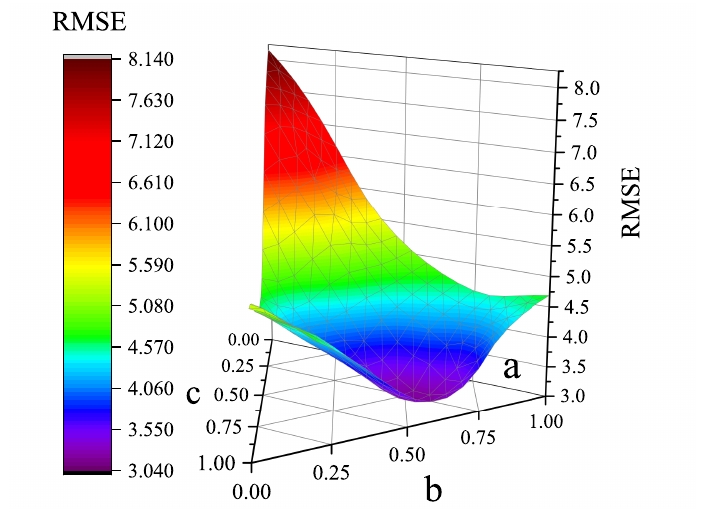
Figure 8. RMSE under different values of ternary